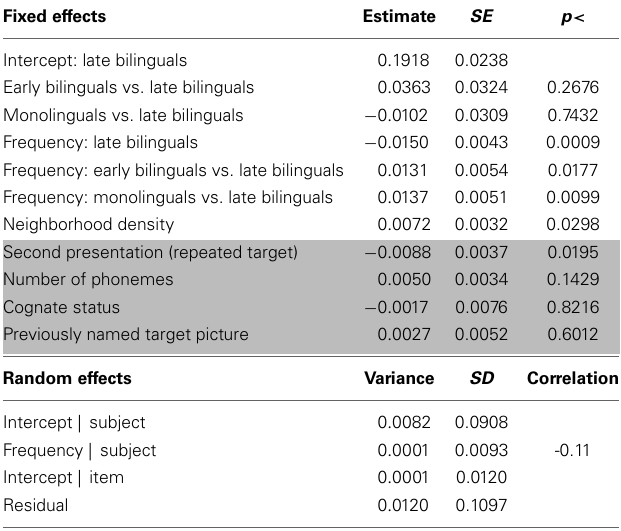
FIGURE 7 | Neighborhood density effects as a function of language proficiency and language status. The y-axis shows the neighborhood density effect for 1 SD change in neighborhood density, extracted from the mixed-effect regression model run on the raw data of the bilingual participants (see text). Each dot represents one participant. The regression line shows the best fit. Table 4 | Results for the analysis of peak dilation